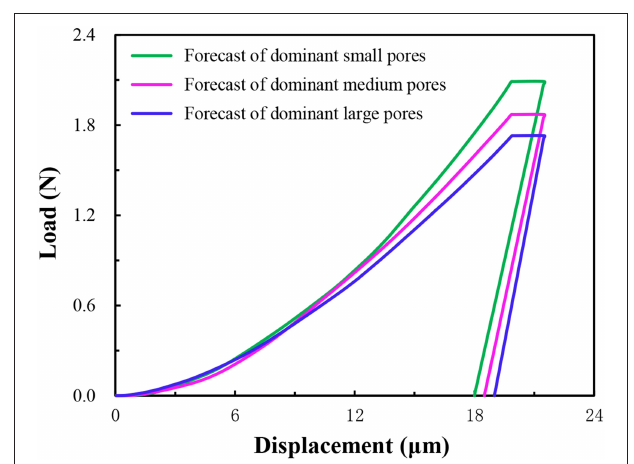
FIGURE 9 | The simulated displacement-load